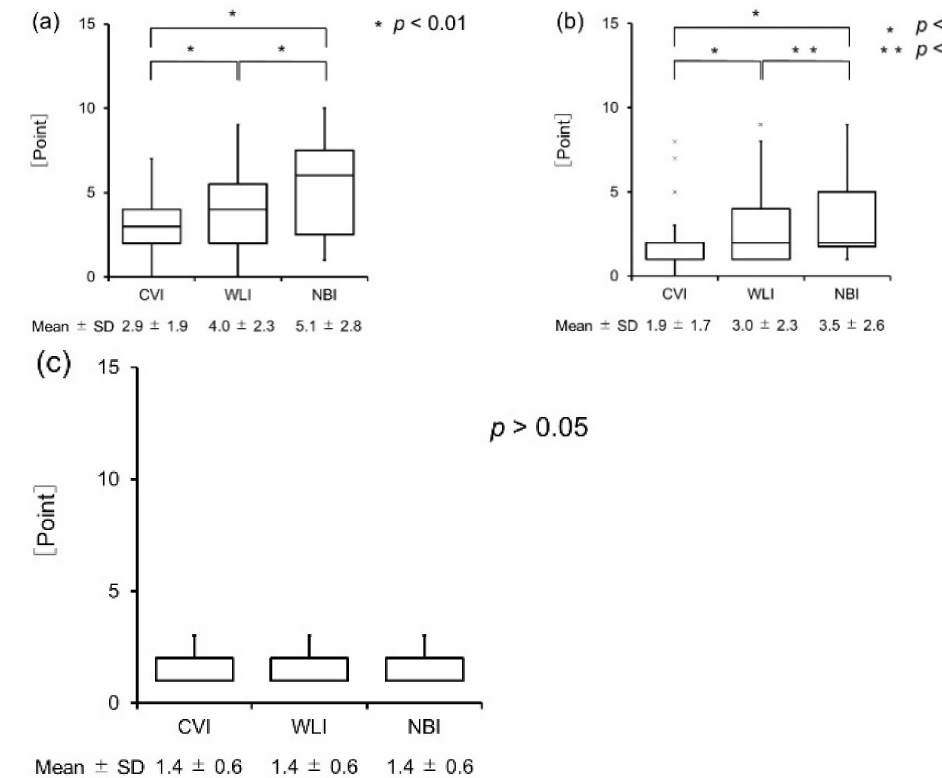
Figure 5. ( a ) Distribution of the OLP lesions by inspection methods. There were significant differences (Wilcoxon’s rank sum test, p < 0.01). ( b ) Distribution of the clinical oral leukoplakia lesions by inspection methods. There were significant differences (Wilcoxon’s rank sum test, p < 0.01, p < 0.05). ( c ) Distribution of the OSCC lesions by inspection methods. There were no significant differences (Wilcoxon’s rank sum test, p >